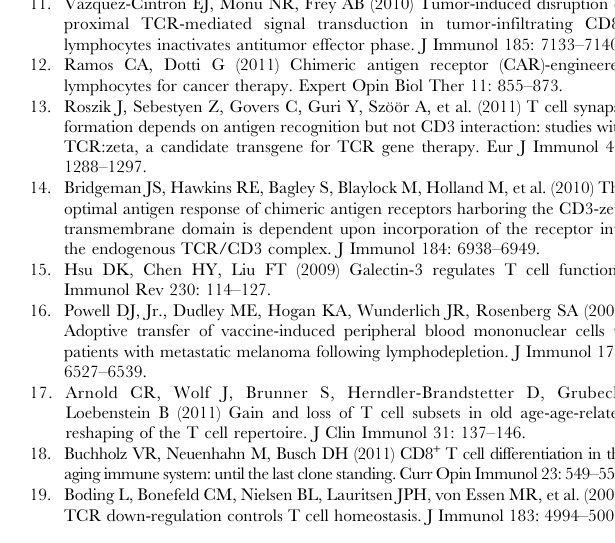
Figure S2 CD7 2 late-stage T cells are hypo-responsive to TCR/CD3 stimulation. The CD7 2 and CD7 + subsets of CD8 + CD45RO + T cells were isolated from the peripheral blood and cultured (10 5 cells/100 m l) with or without the agonistic anti- ml), or with IL-2 (50 U/ml). (A) IFN-gamma in the culture supernatant at day 6 was detected by ELISA. (B) To monitor CD107a + IFN-gamma producing cells, cells were monitored by gamma mAb (25723.11) and the FITC-conjugated anti-CD107a and the mean values 6 SEM are shown. Statistical analyses